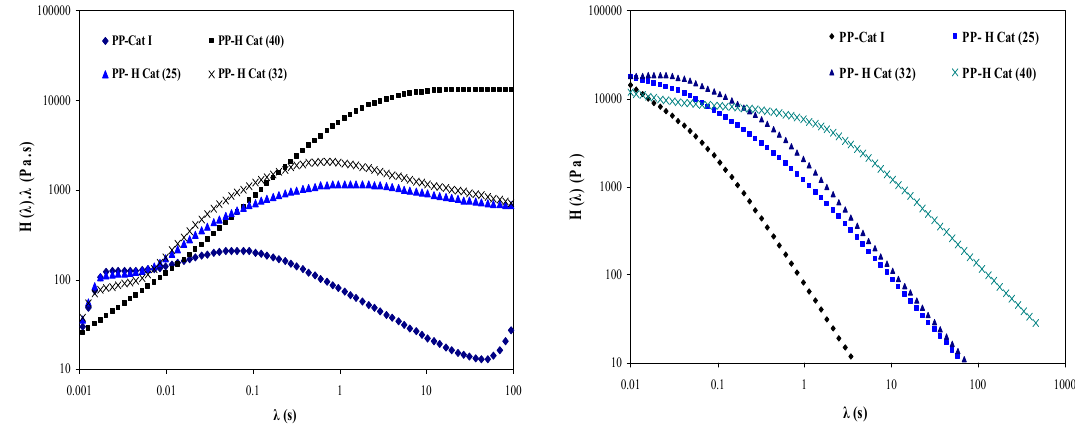
Figure 9. H( λ ) λ and H( λ ) for the PP reactor blends synthesized at different molar ratios of cat (II)/cat (I).